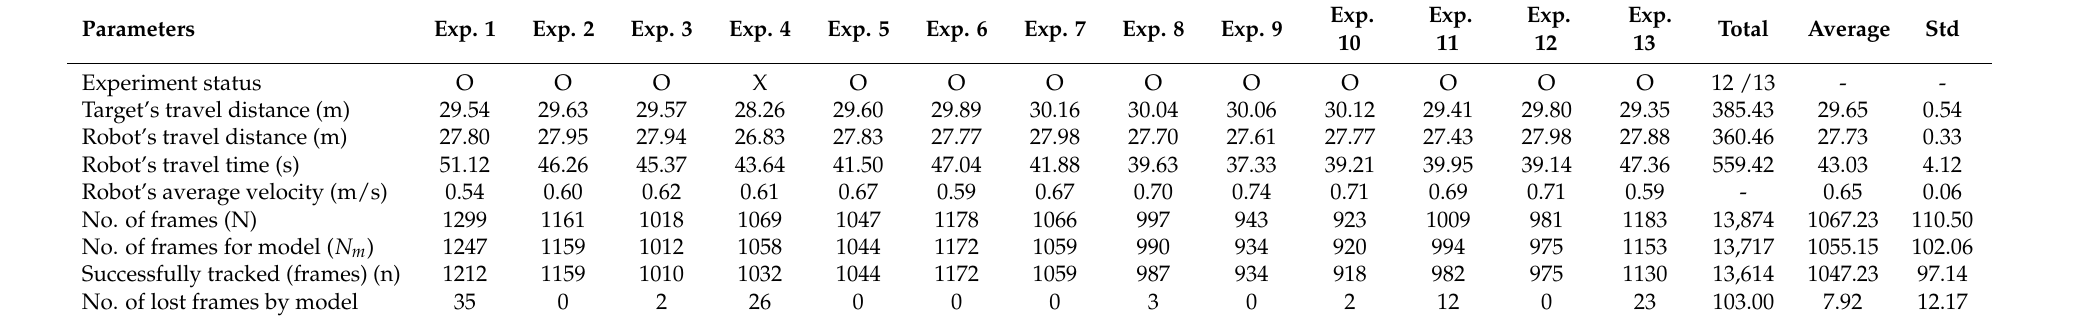
Table 3. Experimental results for the white